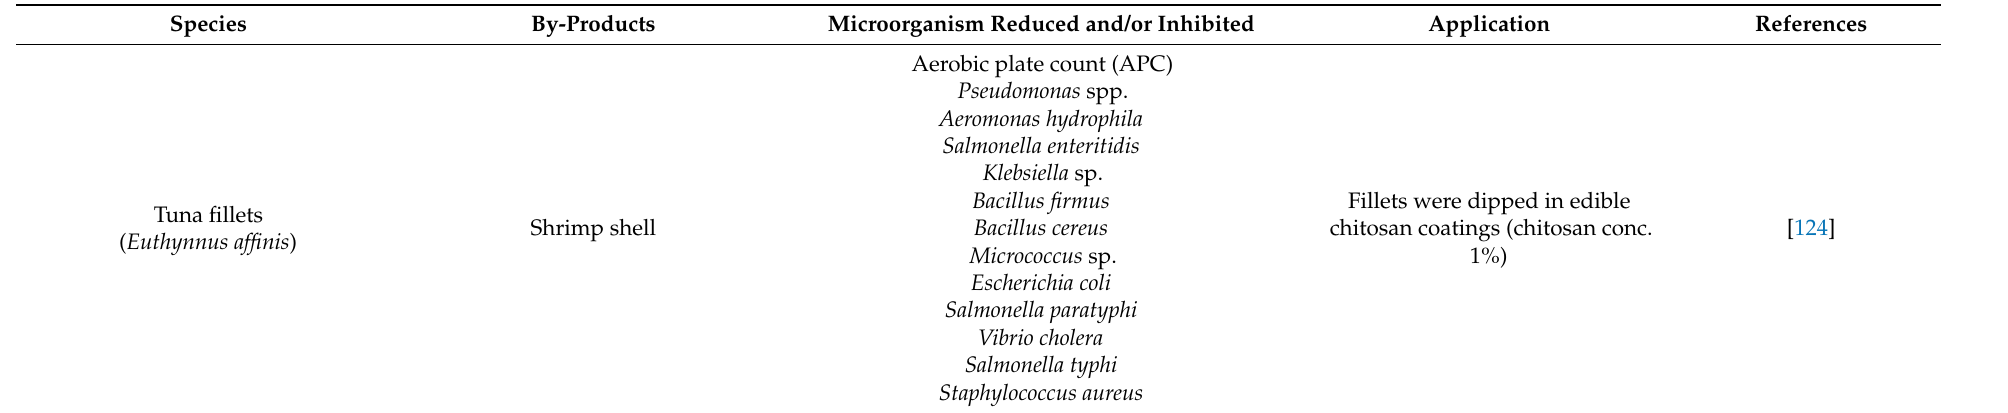
Table 6. Antimicrobial activity of chitosan from crustacean by-products in seafood